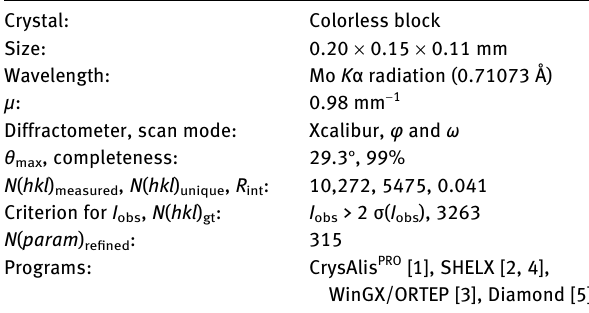
Table  : Data collection and handling.